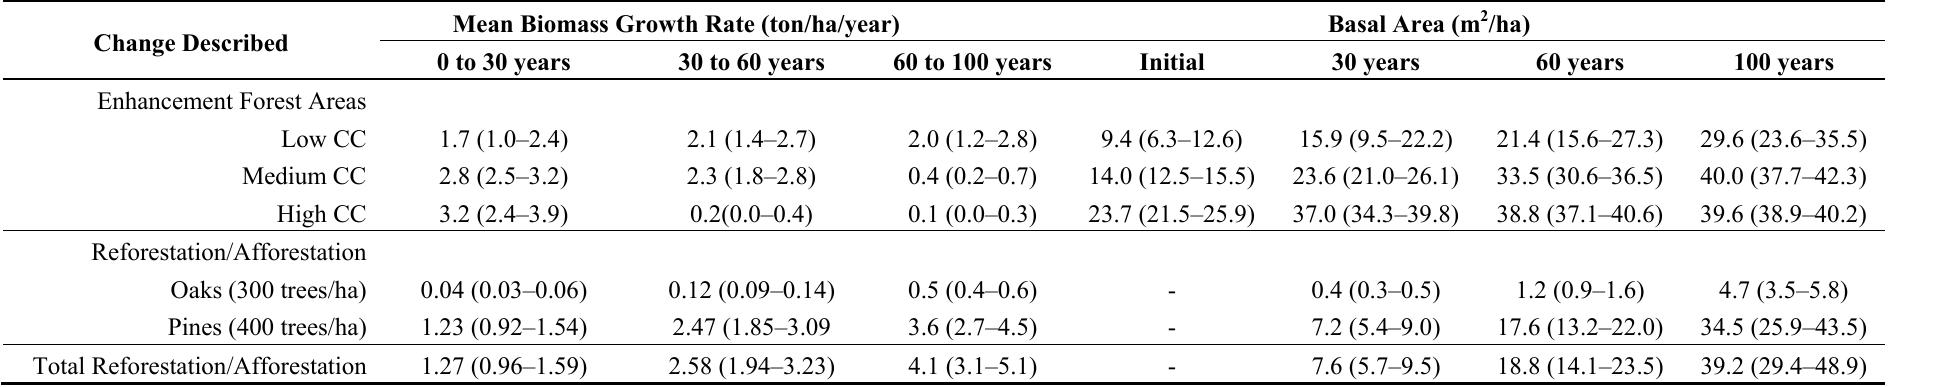
Table 6. Potential for carbon enhancement and sequestration in arboreal aboveground biomass in oak-pine mixes in La Primavera (MtCO Carbon